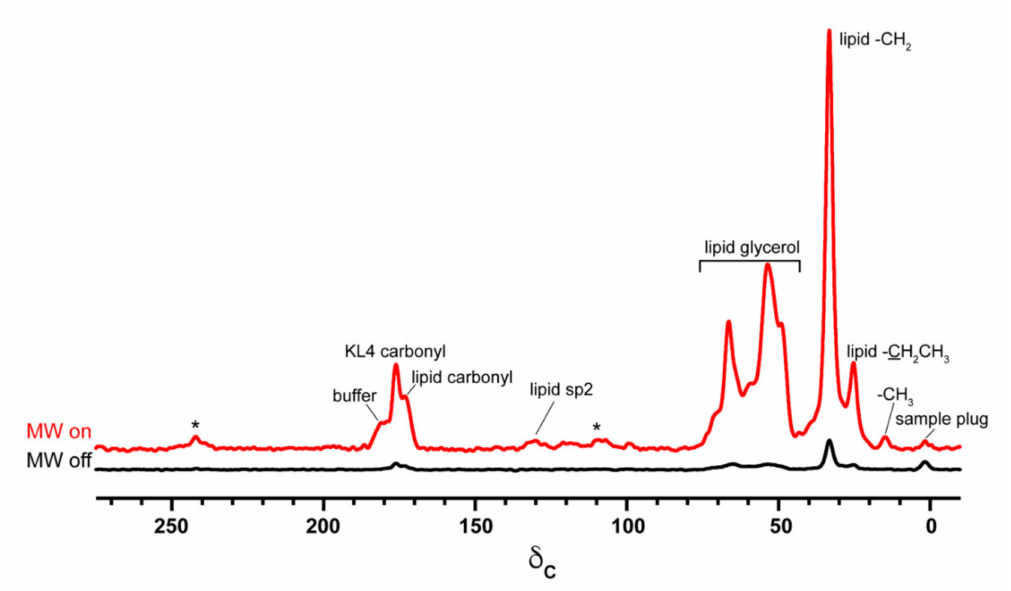
Figure 6. 13 C chemical shift spectra collected with MW o ff (black) or microwave on (red) for a sample containing 5.5 / 2.7 / 2 / 1 DPPC-d 62 / DPPC / POPG / cholesterol MLVs with 2 mol% K 4 equilibrated in a bu ff er containing 10% DMSO-d 6 and 10 mM AMUPol. Spectra were scaled based on the number of transients averaged. The “MW on” spectrum is an average of 32 transients collected in ~2 min; the “MW o ff ” spectrum is an average of 512 transients collected in ~35 min. MAS sidebands are indicated by an *. Since the DMSO is deuterated, solvent resonances contribute minimally to the spectrum. Table 1. DNP enhancements for di ff erent samples. All samples were comprised of 5.5 / 2.7 / 2 / 1 DPPC-d 62 / DPPC / POPG / cholesterol lipids reconstituted in UB, pH 7.4, containing 10 mM AMUPol and 10% DMSO. Peptide-containing samples incorporated KL 4 with a single 13 C isotope at the